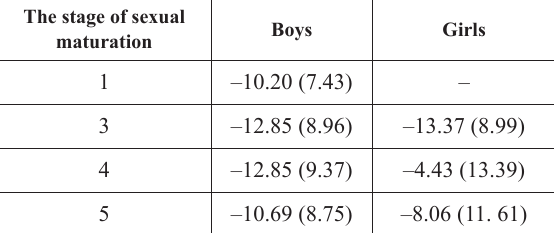
Table 3. Distribution of the mean score of objectified body consciousness scale (SD) in the groups by